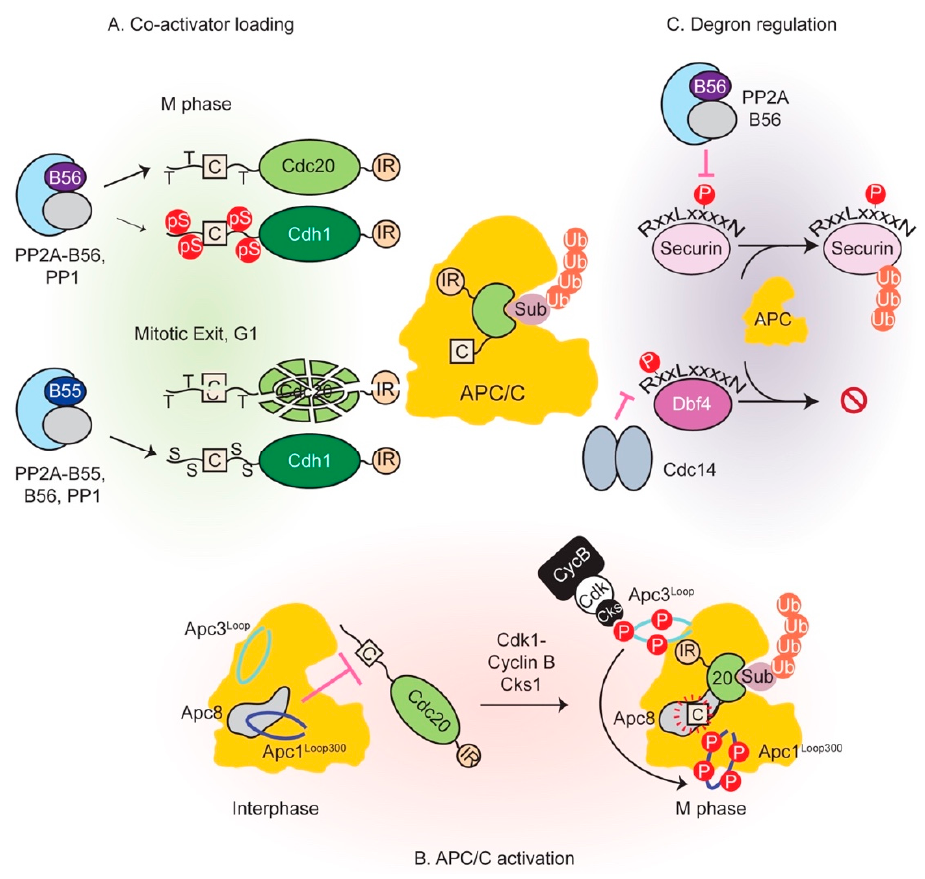
Figure 5. Phosphatases regulate multiple aspects of APC/C function. ( A ) In mitosis, PP2A-B56 and PP1 dephosphorylate phosphothreonine-rich Cdc20 N-terminus to promote its interaction with the APC/C. During mitotic exit and in G1, PP2A-B55 (and other mitotic exit phosphatases) dephosphorylate serine-rich Cdh1 N-terminus. In conjunction with other unknown mechanisms, this promotes co-activator exchange and Cdc20 degradation. ( B ) Apc1 Loop300 occludes the C box binding site within Apc8 and prevents Cdc20 loading. Recruitment of mitotic kinases by Apc3 Loop leads to Apc1 Loop300 phosphorylation (likely opposed by as-yet-unknown phosphatases) and Cdc20 loading. ( C ) Phosphoregulation of degrons influences substrate degradation by the APC/C. Securin phosphorylation at position 6 within the D-box stimulates its degradation. PP2A-B56 opposes this process. Budding yeast Dbf4 phosphorylation at position 2, removed by Cdc14, is refractory to its degradation. See text for details. Abbreviations: CycB, Cyclin B; Sub, substrate.